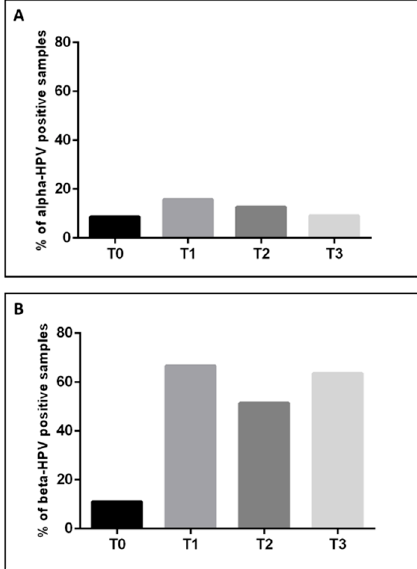
Figure 1. Frequencies of alpha ( A ) and beta ( B ) HPV samples in newborns at birth (T0), 1 day to 1 month old (T1), >1 month to 12 months old (T2) and >12 months old (T3).